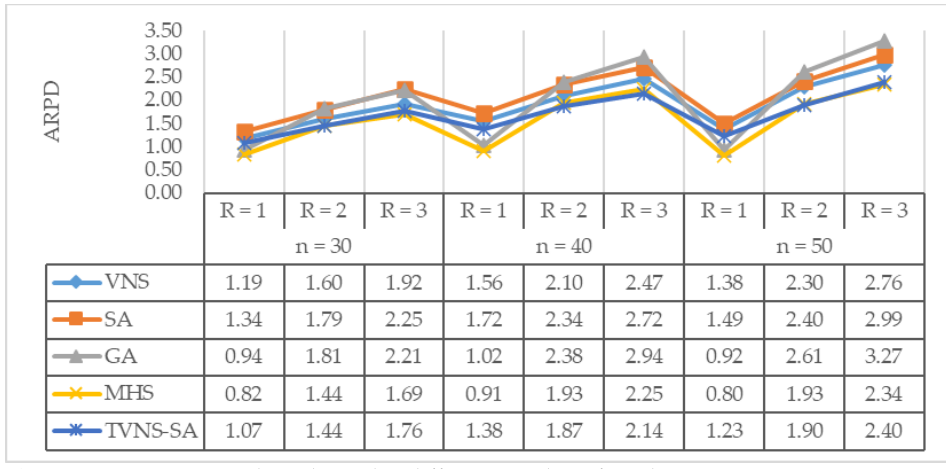
Figure 11. Computational results with a different number of resources.